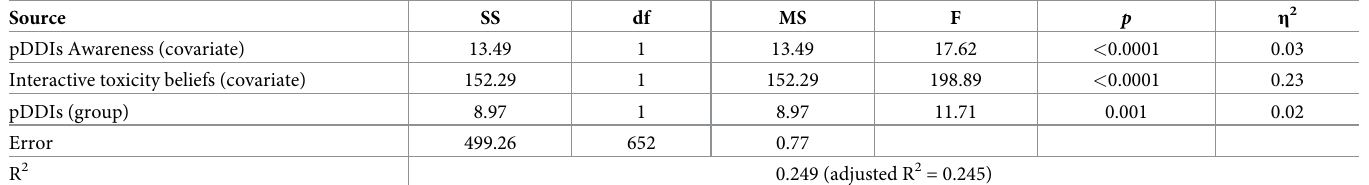
SS = sum of squares; df = degrees of freedom; MS = Mean square; η 2 = partial eta